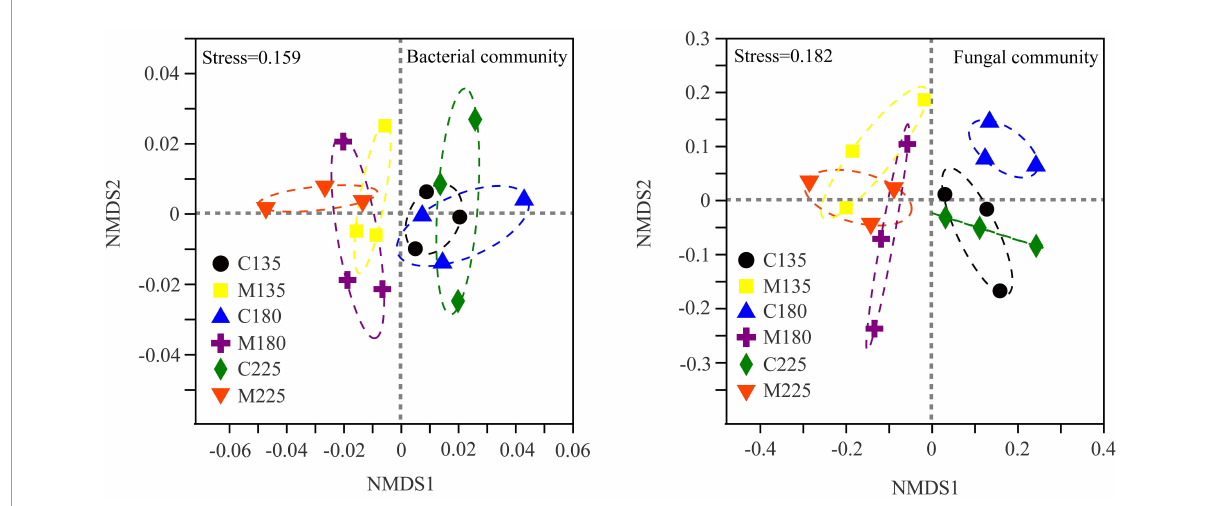
FIGURE3 Non-metric multidimensional scaling analysis of soil microbial communities under different nitrogen and manure treatments. M and C indicate treatments with and without chicken manure application, respectively.